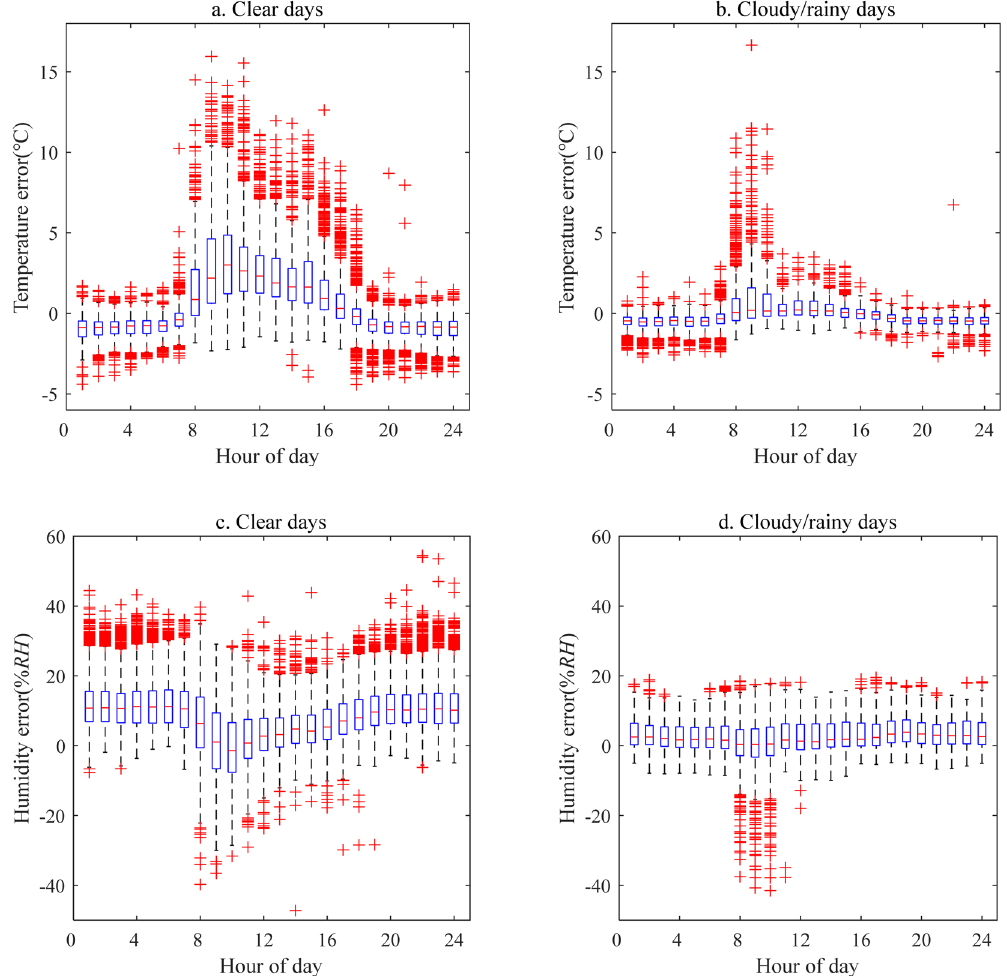
Figure 4. Diurnal variations in the errors in temperature ( a , b ) and humidity ( c , d ) observed by wireless sensors on clear and cloudy/rainy days. The symbols in the figure are the same as those in Fig.